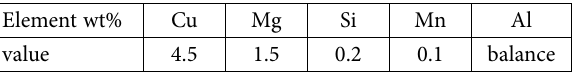
Table 2. Chemical composition of sintered base alloy by